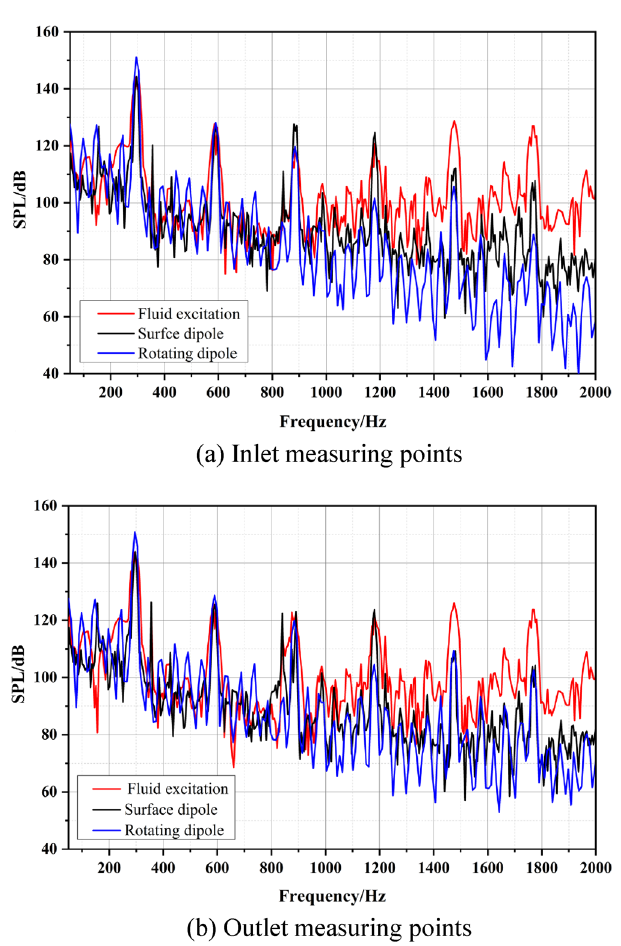
Figure 8. The spectrum of infield noise by different